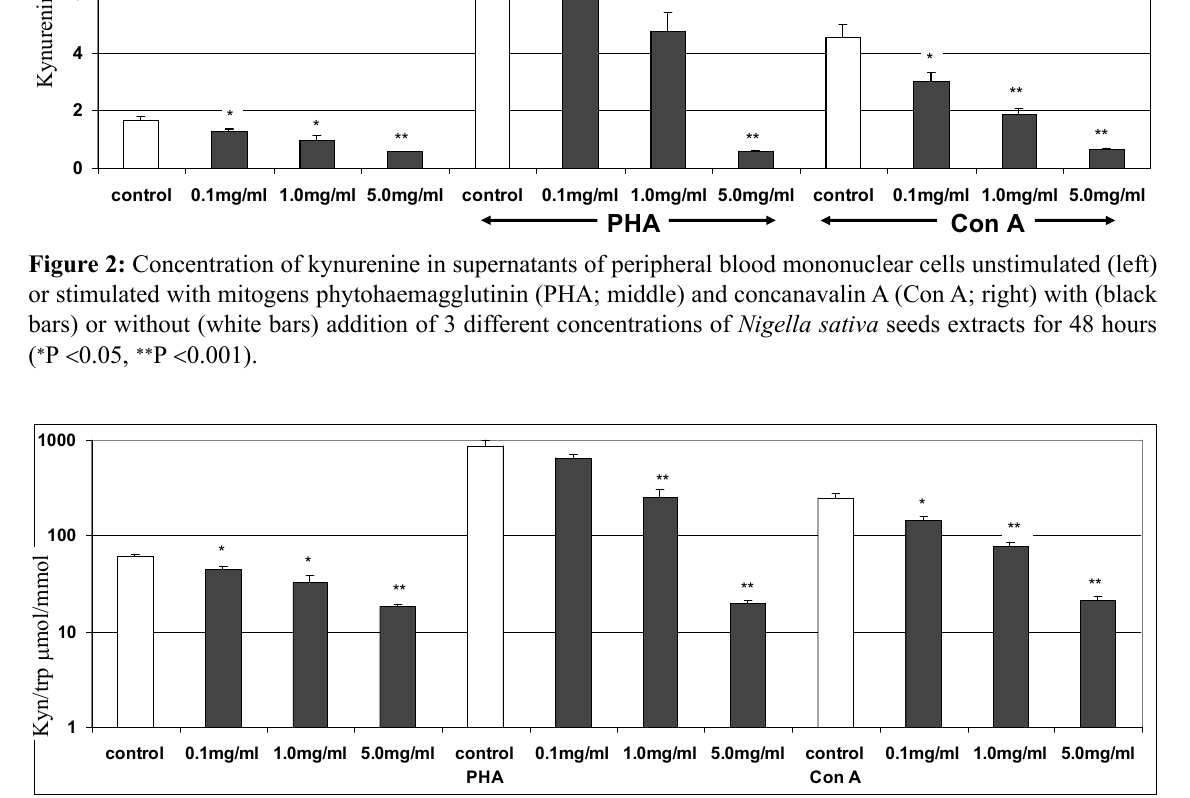
Figure 3 : Kynurenine to tryptophan ratio (Kyn/trp) in supernatants of peripheral blood mononuclear cells unstim- ulated (left) or stimulated with mitogens phytohaemagglutinin (PHA; middle) and concanavalin A (Con A; right) with (black bars) or without (white bars) addition of 3 different concentrations of Nigella sativa seeds extracts for 48 hours ( ∗ P < 0.05, ∗∗ P <